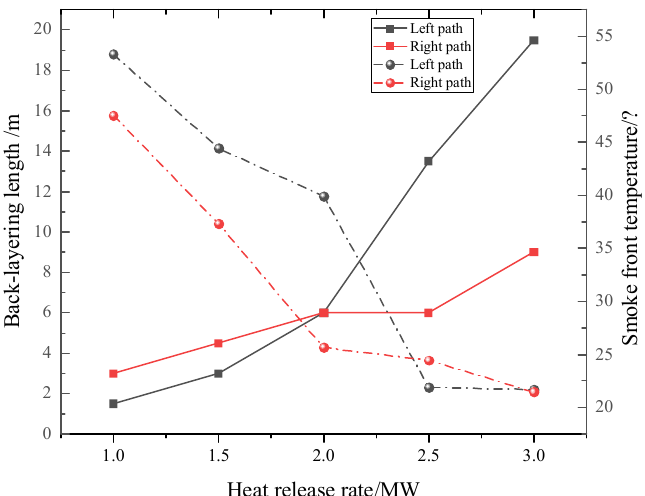
Figure 16. Smoke backflow distance and smoke backflow front temperature variation under different heat release rate.